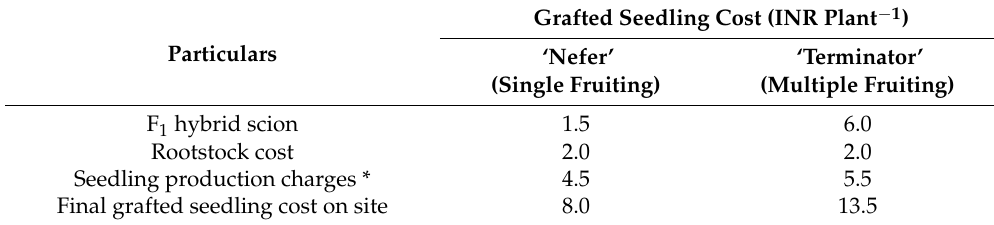
Table 2. Effect of structures and graft combinations on growth parameters. Treatments